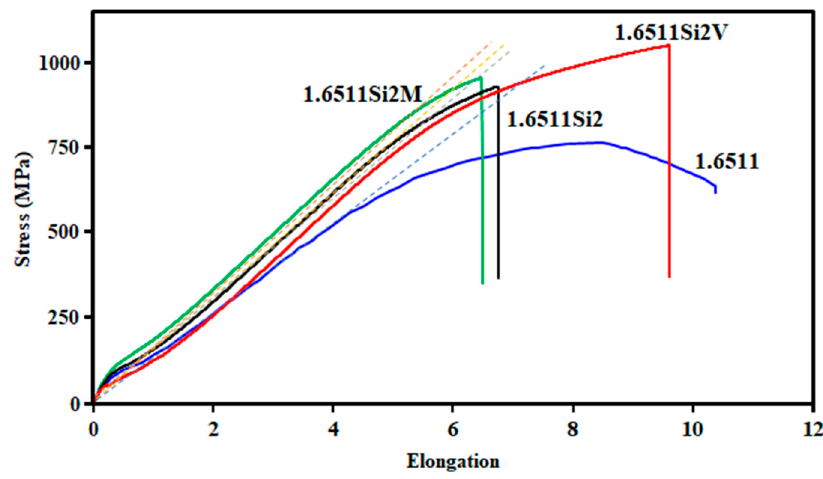
Figure 12. Typical engineering stress–strain curve of samples . Table 2. Mechanical properties, including the yield stress (YS, with 0.2% offset) and ultimate tensile strength (UTS) of the samples.